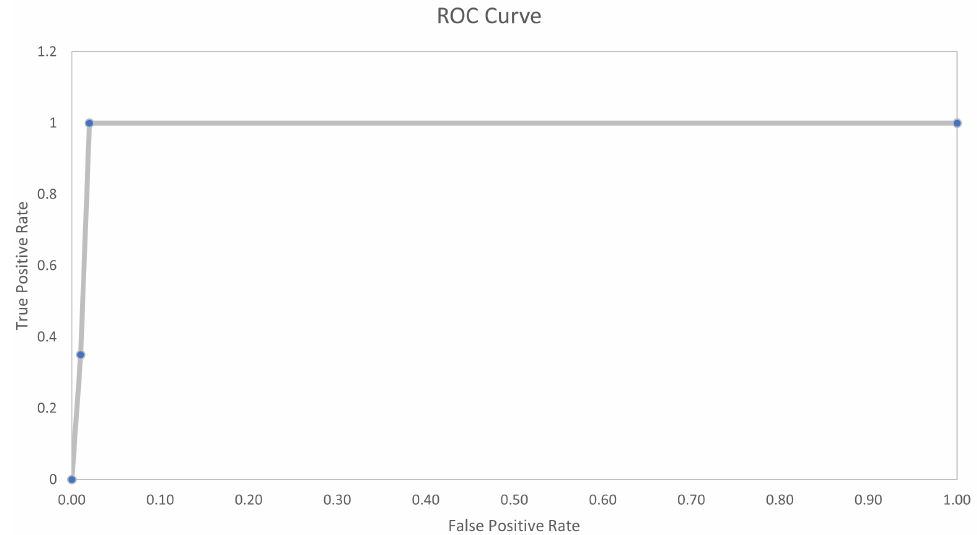
Figure 11. Neural network ROC